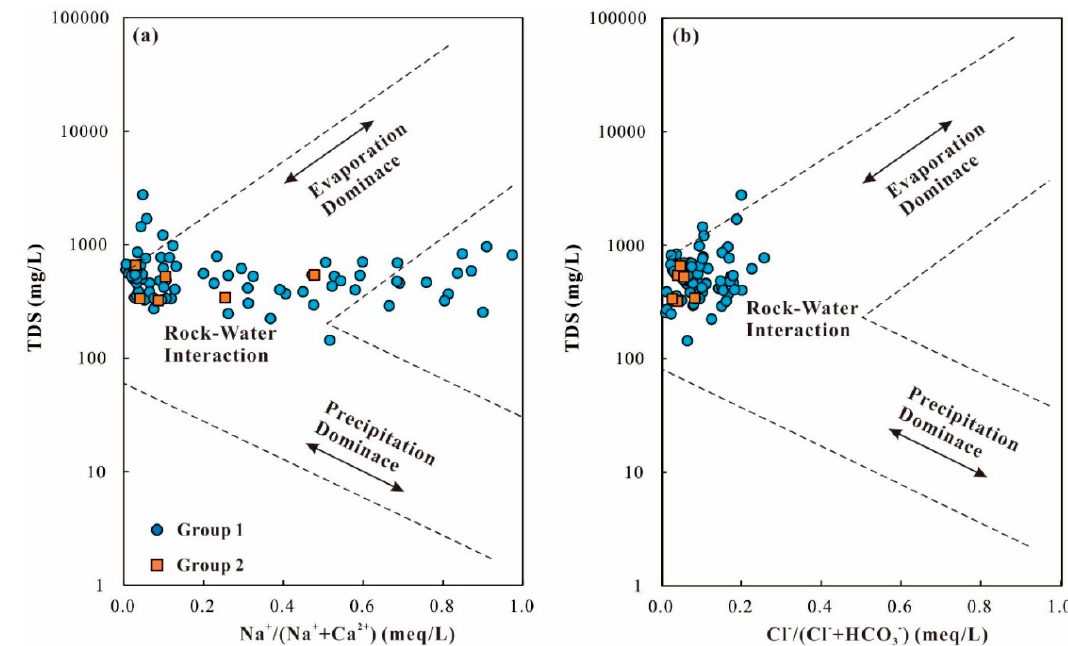
Figure 5. Gibbs diagrams for groundwater samples, (a) Na + /(Na + + Ca 2+ ) vs. total dissolved solids (TDS), (b) Cl − /(Cl − + HCO 3 − ) vs. total dissolved solids (TDS).